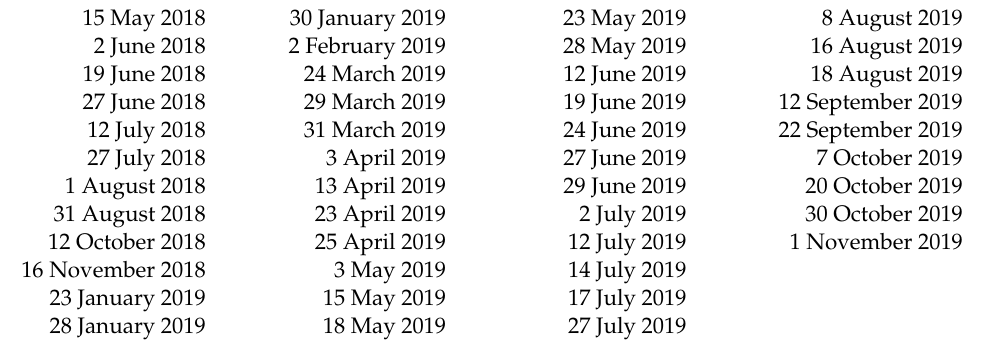
Table A1. Dates of the 45 Sentinel-2 images used for the automatic extraction of the shoreline.